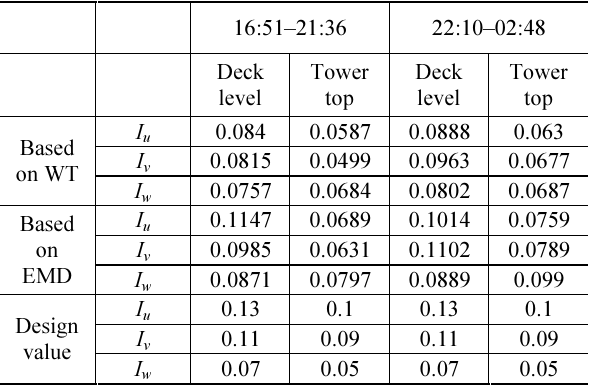
Table 1. Comparison of average values of turbulence intensity